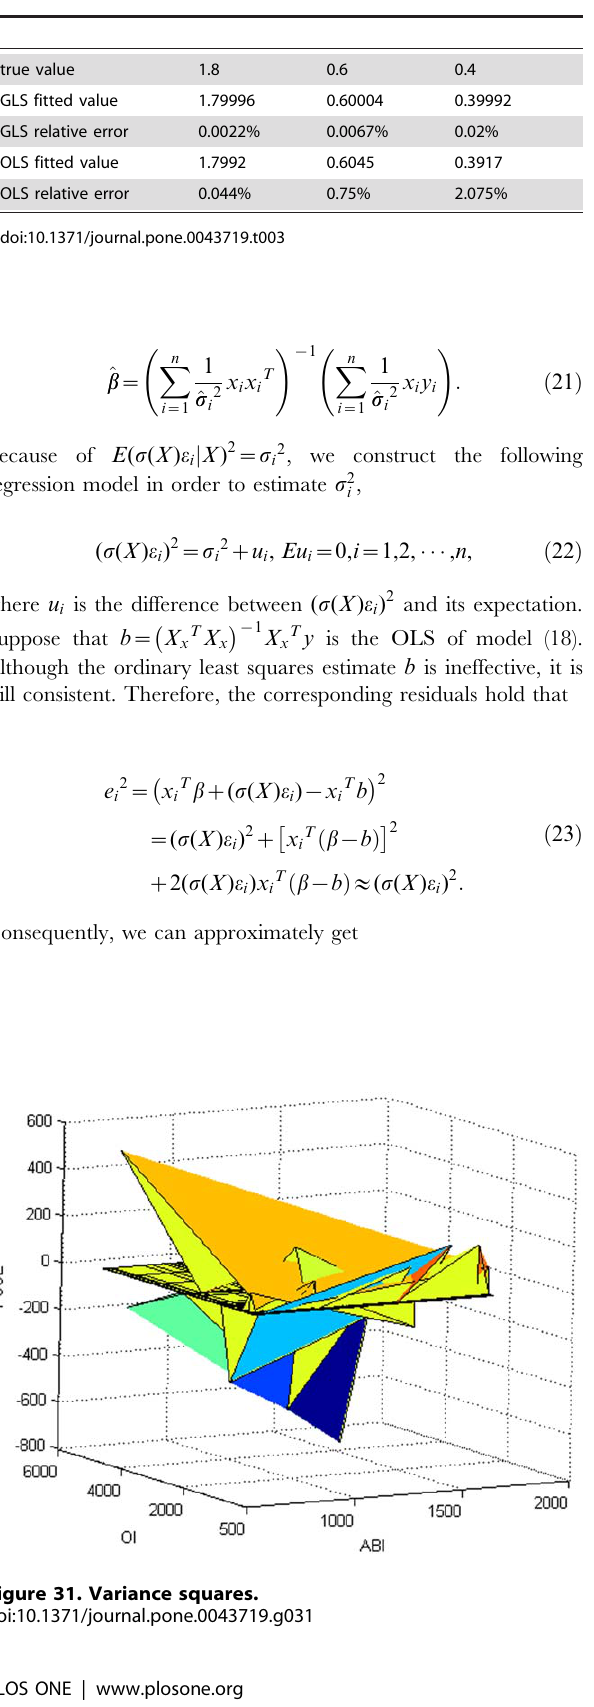
, b , and b of GLS and 0 1 2